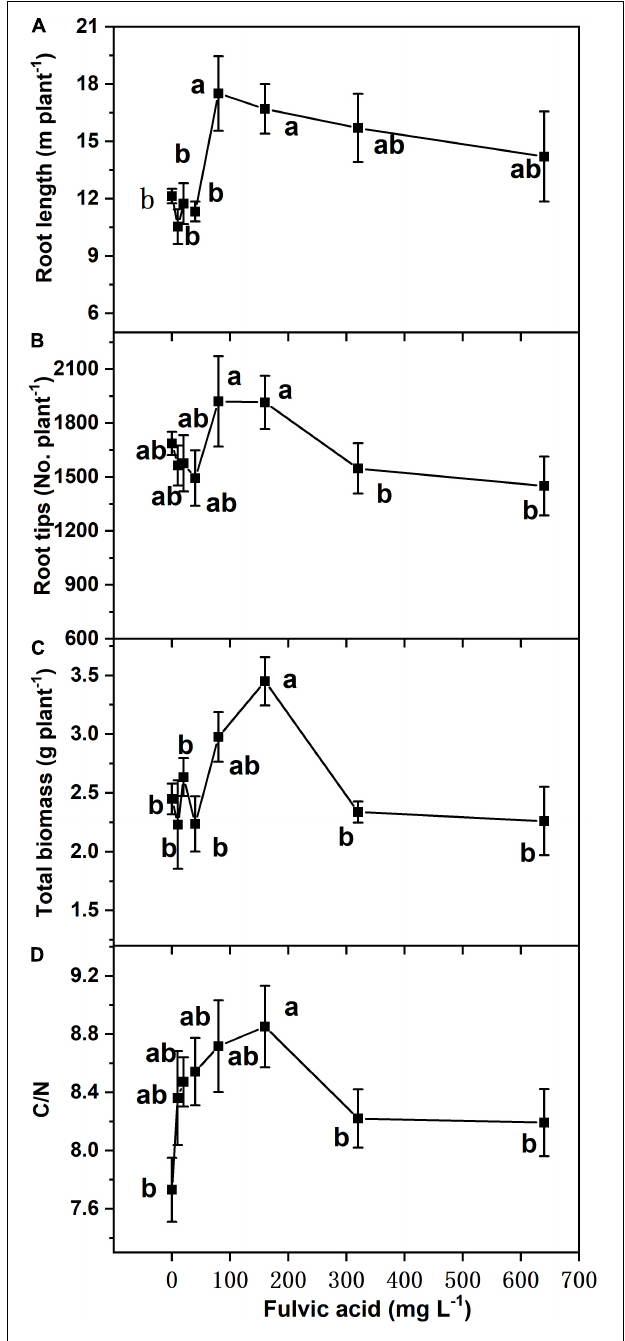
FIGURE 4 | The effect of fulvic acids on root length (A) , root tips (B) , total biomass (C) , and ratio of carbon to nitrogen (D) in leaves of tomato plants cv. Zizhenzhu grown in hydroponics for 21 days. Data are means ± s.e ( N = 4). The same letters denote insignificant differences ( P < 0.05) among treatments according to Duncan’s new multiple range test (Experiment